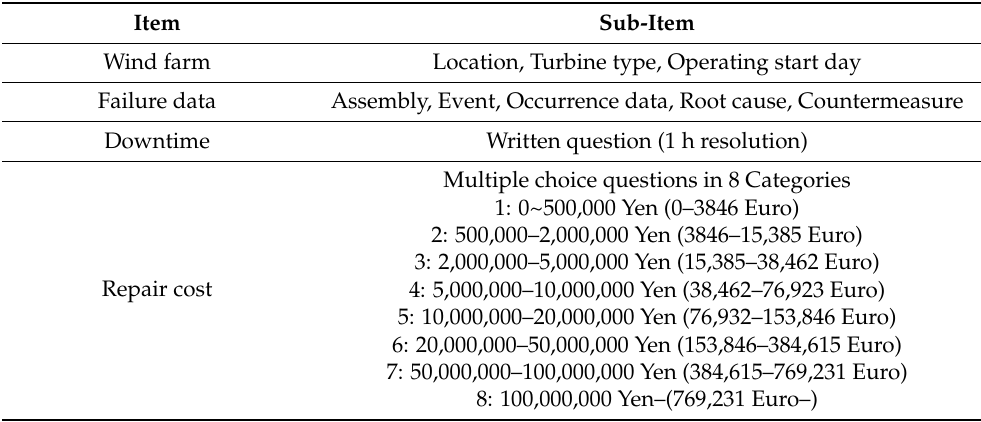
Table 1. Description of NEDO failure